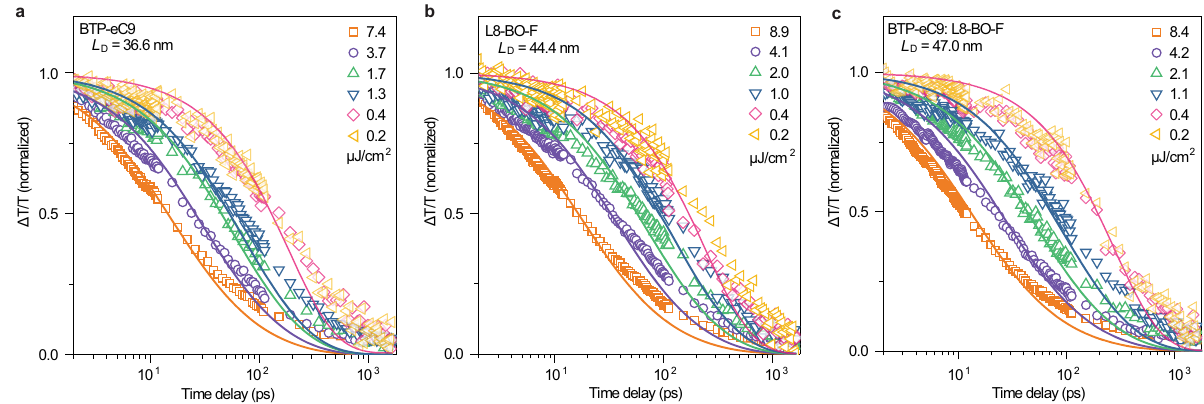
Fig. 2 Exciton diffusion length measurements. The dynamics of the singlet excitons measured with the 670 nm pump excitation at different densities in fi lms of ( a ) BTP-eC9 (850 nm), ( b ) L8-BO-F (814 nm), ( c ) BTP-eC9:L8-BO-F (850 nm).The fl uence-dependent singlet exciton decays are fi tted to the exciton annihilation model